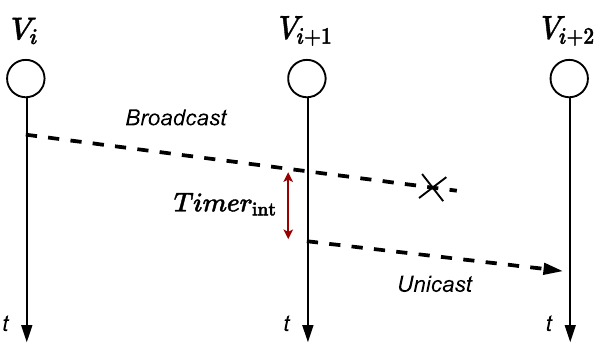
Figure 6. Node v i+ 1 retransmits to node v i+ 2 .